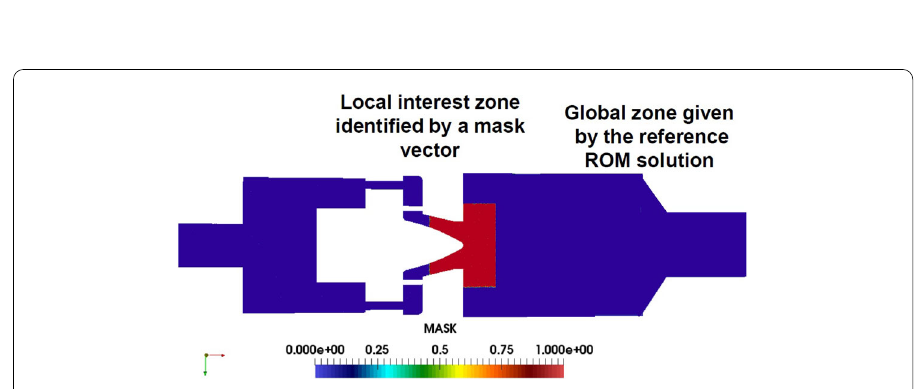
Fig. 25 Mask vector that defines the RFD in red (cid:2) R of interest around the geometrical variations. In blue, (cid:2) \ (cid:2) R